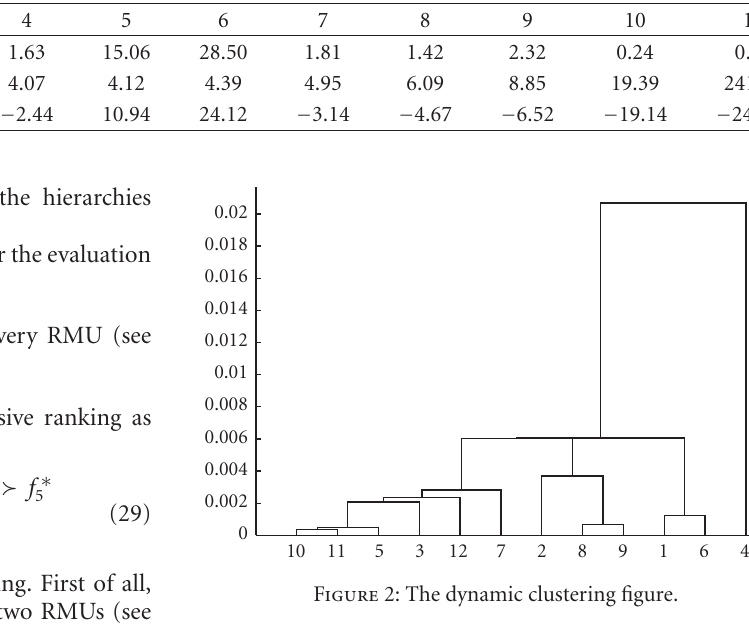
Table 8: The values of F and the critical values of F 0 . 05 .